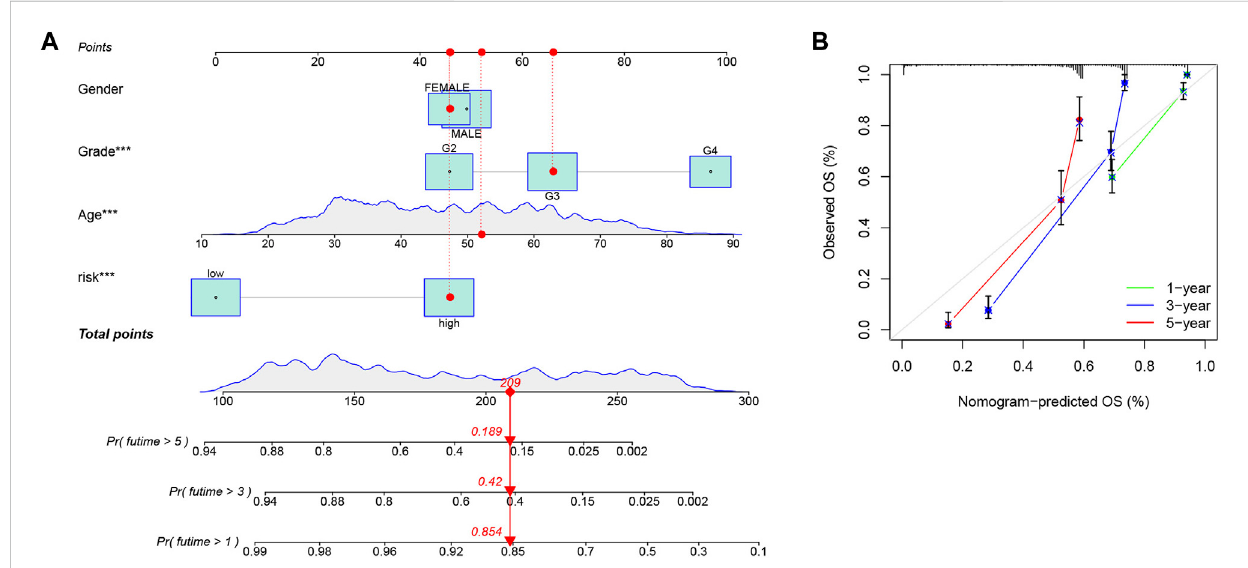
FIGURE 8 Construction of a nomogram. (A) Prediction of 1-, 3-, and 5-year survival, based on the CRG-score and clinicopathological characteristics by a nomogram. The corresponding values of Gender, Grade, Age and Risk group were obtained by using their positions at the “ Points ” abscissa. A patient ’ s total point is the sum of the four values. And by using the total points coordinate scale, we can get the prognosis prediction of the patient. (B) The calibration curve of the nomogram. The more the prediction curve matches the grey curve, the better the prediction effect will be